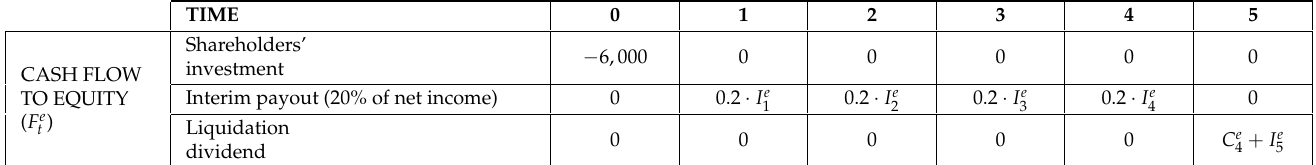
Table 7. Breakdown of CFE (payout ratio = 20% of net income).